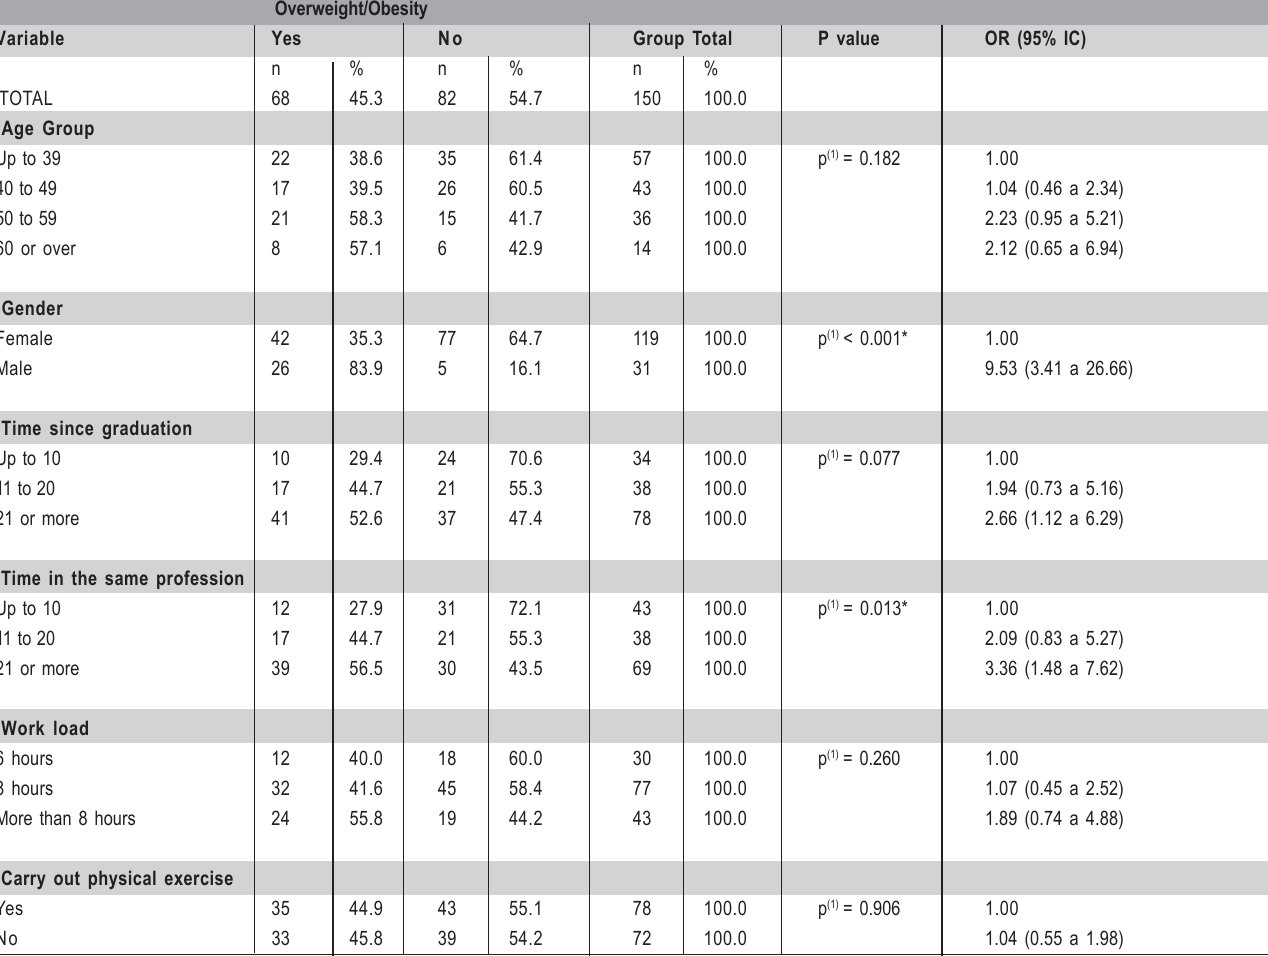
Table 1 - Assessment of overweight/obesity according to age, gender, time since graduation, time in the same occupation, working hours and physical